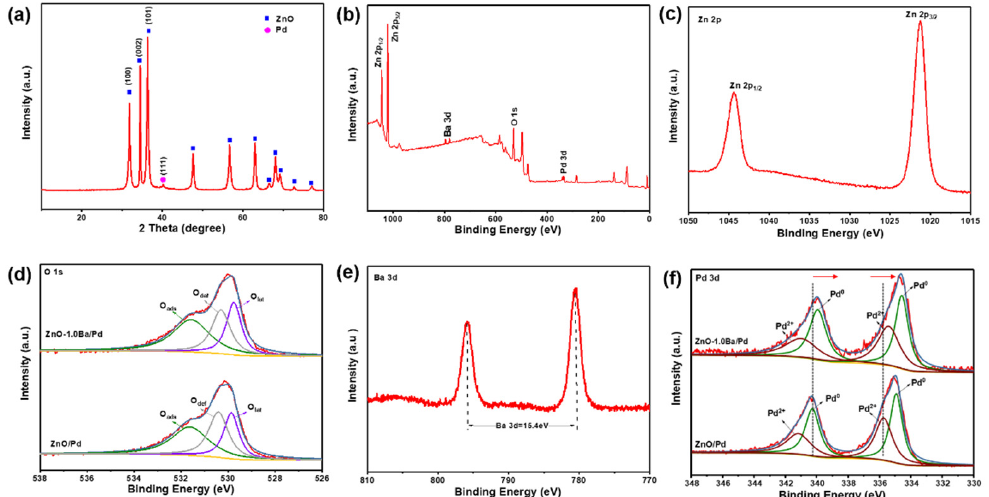
Figure 3. XRD patterns of ( a ) ZnO-1.0Ba/Pd; ( b ) overall XPS spectra of ZnO-1.0Ba/Pd, XPS spectra of ZnO-1.0Ba/Pd; ( c ) Zn 2p spectrum; ( d ) O 1s spectrum; ( e ) Ba 4d spectrum; ( f ) Pd 3d